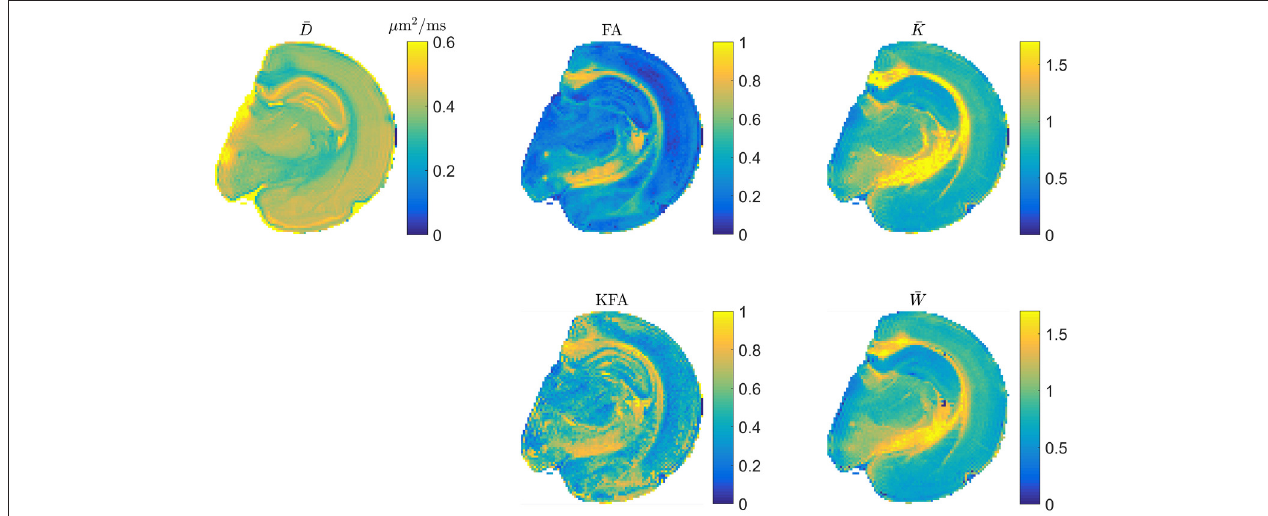
FIGURE 4 | Example maps of typical DTI and DKI parameters in fixed rat brain. The two mean kurtosis definitions are shown and seen to provide similar contrast. Figure adapted from Hansen and Jespersen [ 37] with permission.